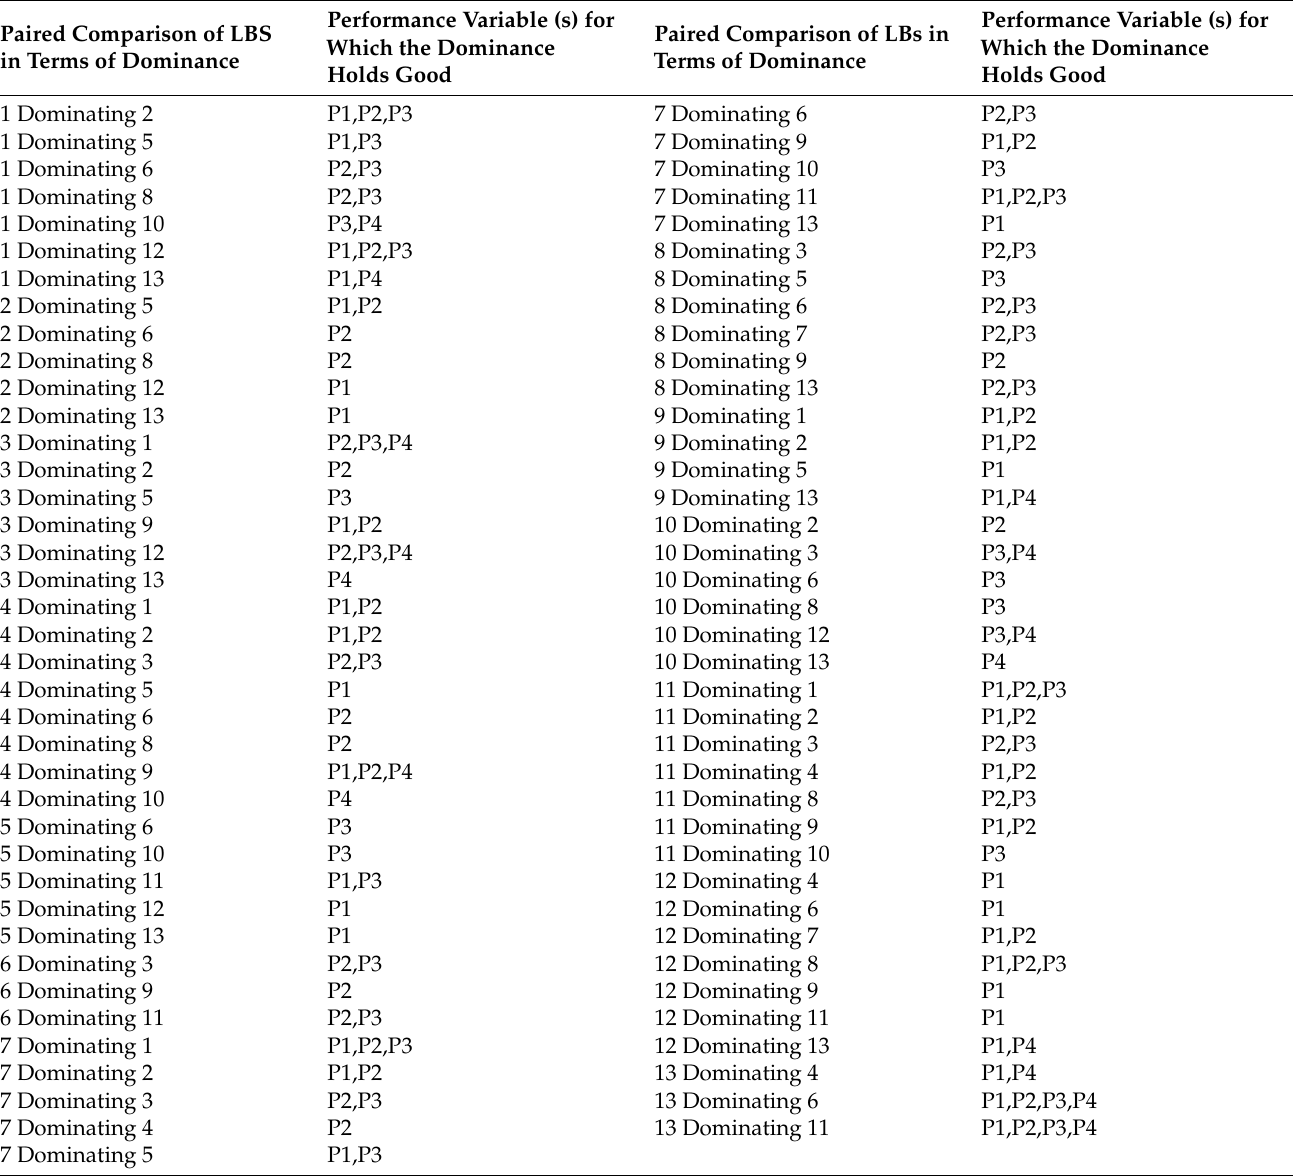
Table 9. Interpretive logic lean knowledge base